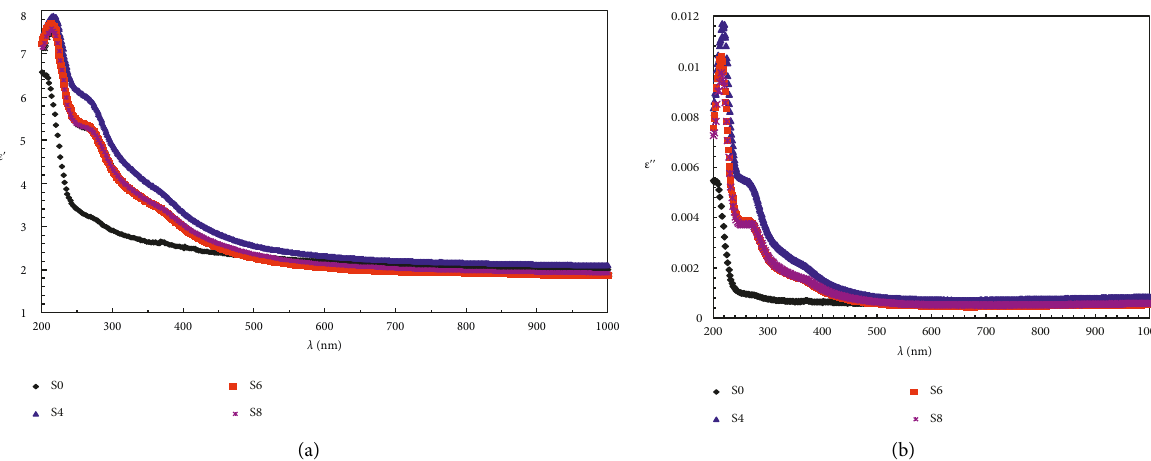
Figure 9: Plots of (a) dielectric constant ( ε